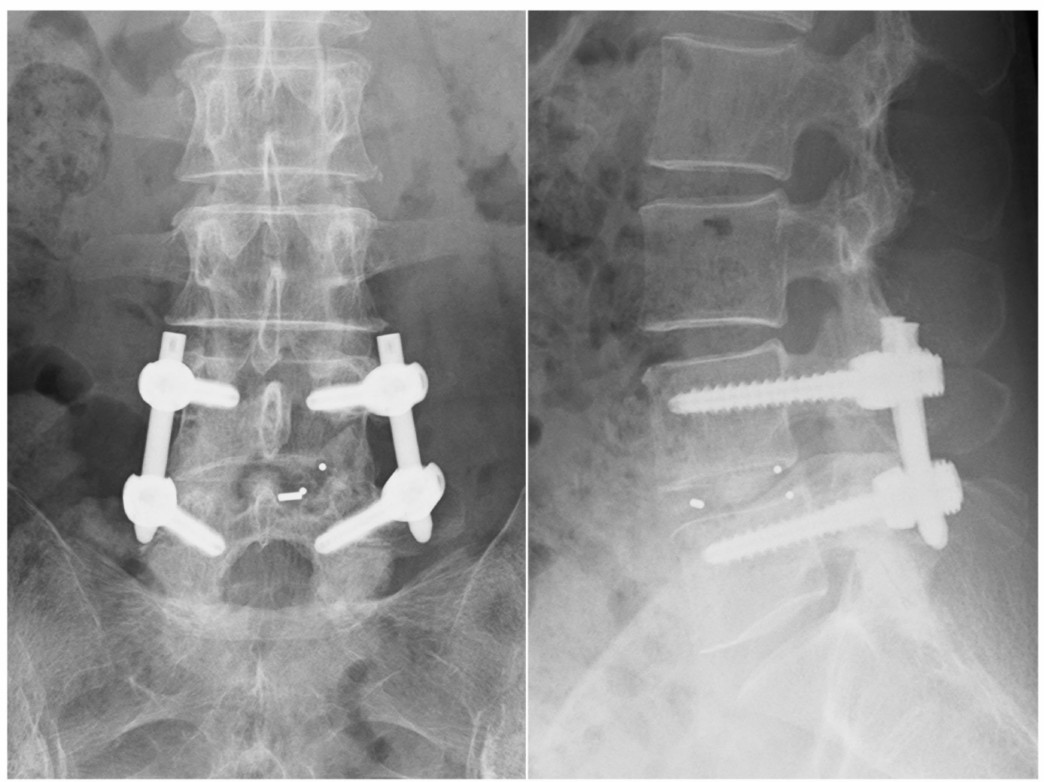
Figure 2. Postoperative X-ray after MIS-TLIF (coronal and lateral views). MIS-TLIF, minimally invasive transforaminal lumbar interbody